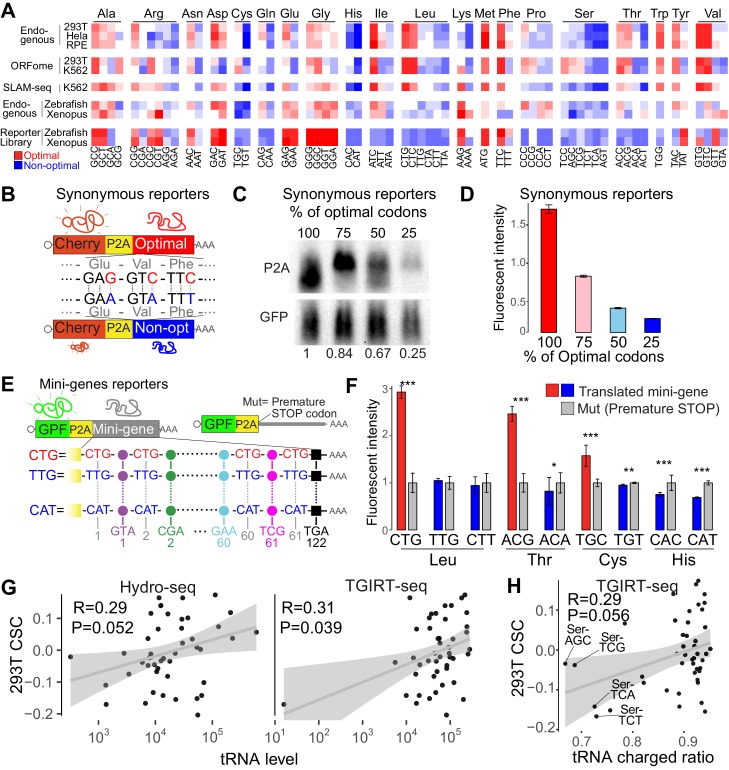
Synonymous codons affect mRNA stability in human lines.(A) Heatmap showing the codon stability coefficient (CSC) sorted by the encoded amino-acid, for the indicated cell lines and approaches used to measure mRNA stability. The codon optimality scores calculated in zebrafish and Xenopus are also shown (Bazzini et al., 2016). (B) Diagram of the ‘Synonymous’ reporters. mRNAs differing only in synonymous mutations with different regulatory effects on mRNA stability. Each mRNA contains the coding region for mCherry fluorescent protein followed by a cis-acting hydrolase elements (P2A) and a coding region that different in the proportion of optimal and non-optimal codons but encoding for the same peptide (synonymous mutations). (C) Northern-blot showing that the synonymous reporter enriched in more optimal codons presented higher RNA level. GFP was used as internal control. Relative normalized quantifications are indicated. (D) The fluorescent intensity correlated with the proportion of optimal codon of each of the four reporter mRNAs differing only in synonymous codons. (E) Scheme of ‘Mini-gene’ reporters: all mini-genes mRNAs contain the coding region for Green fluorescent protein followed by a cis-acting hydrolase elements (P2A) and a coding region that contain the 61 different coding codons (colored circles) alternated with a single codon that give name to the mini-gene. The counterpart pair of each mini-gene (Mut) contains a single mutation in the P2A that prevent the coding region enriched in one particular codon to be translated. (F) Fluorescent GFP intensity of the indicated mini-genes normalized with internal control (mCherry). Unpaired t.test is used *p<0.05, **p<0.01, ***p<0.005. (G) Scatter plots showing the 293T CSC (endogenous mRNA) and tRNA levels quantified by Hydro-seq (Gogakos et al., 2017) and TGIRT-seq (Evans et al., 2017), Spearman rank correlations indicated. (H) Scatter plots showing the 293T CSC (endogenous mRNA) and tRNA charged ratios quantified by TGIRT-seq with periodate oxidation (Evans et al., 2017). The four nuclear tRNAs encoding for Serine are indicated. Spearman rank correlations indicated.
10.7554/eLife.45396.012Figure 3—source data 1.Reporter sequences and oligos used for Figure 3.